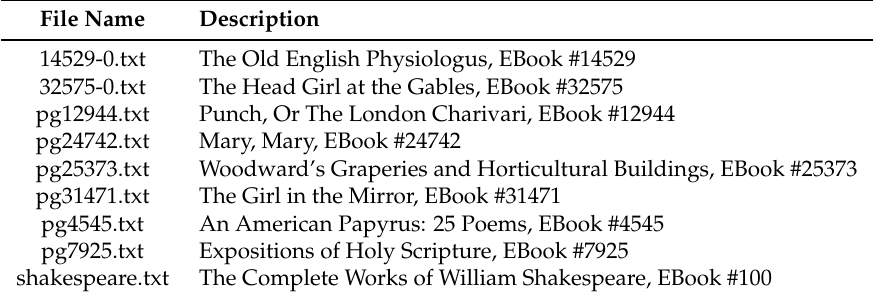
Table 2. Data sets used for the experimentation measures, all from the Project Gutenberg.